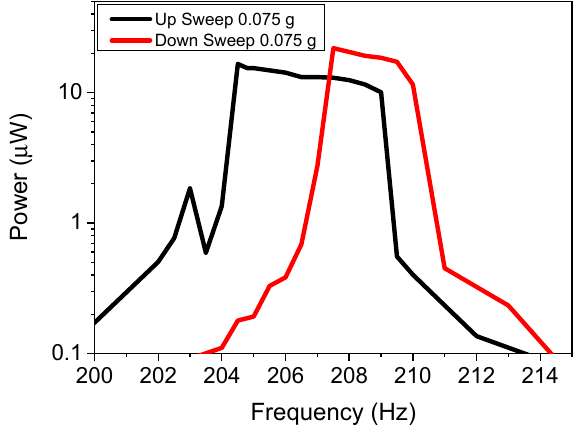
Figure 8. In-plane power as a function of frequency results for upwards and downwards sweeping frequencies for various acceleration values.